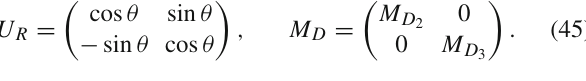
) the scalars are ( M H (cid:2) 2 (in TeV). Horizontal dashed lines represent 3 σ range of Planck limit on relic